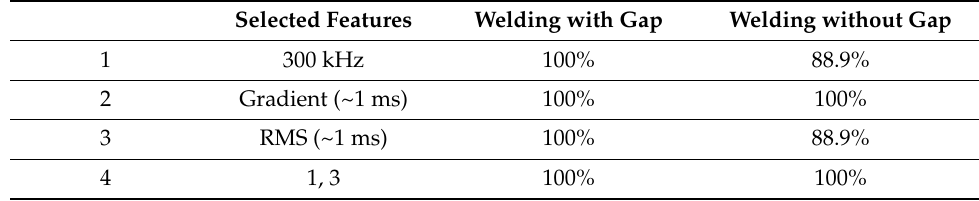
Figure 14. Classification index for each 1 ms interval: ( a ) RMS and ( b ) gradient of signals. Table 3. Selected features for HMM.